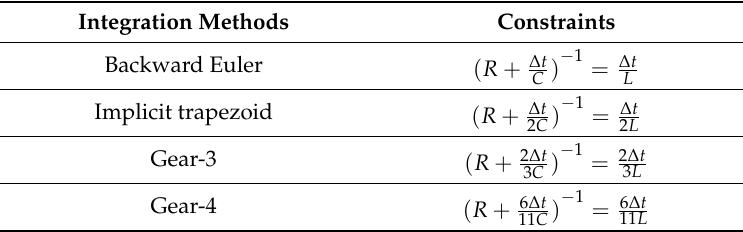
Table 4. The constraints of different integral